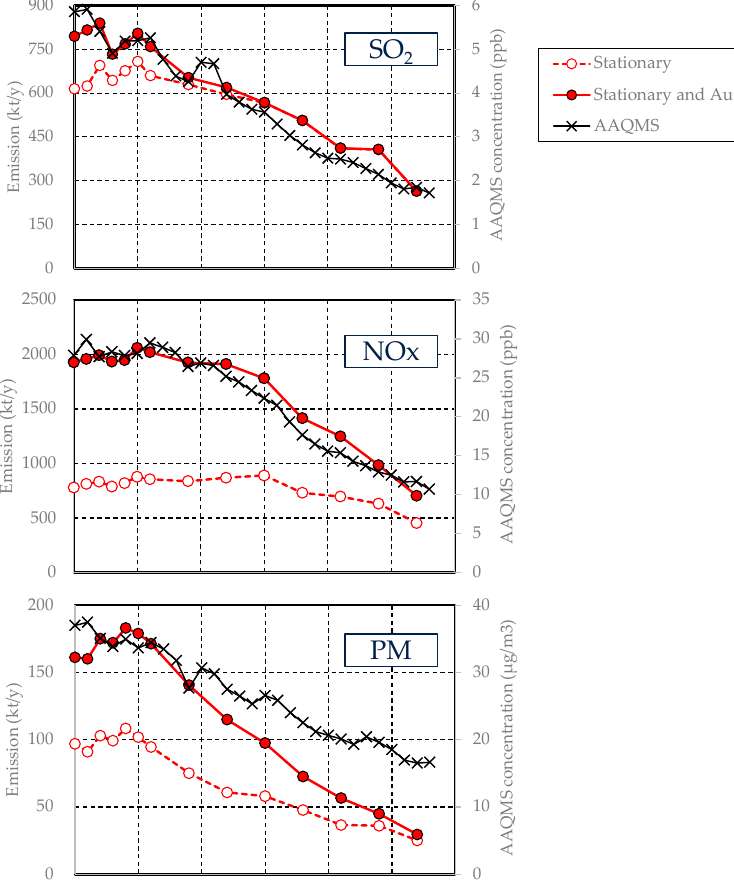
Figure 8. Anthropogenic emission data and annual average concentrations at the AAQMS for SO 2 , NOx, and PM.